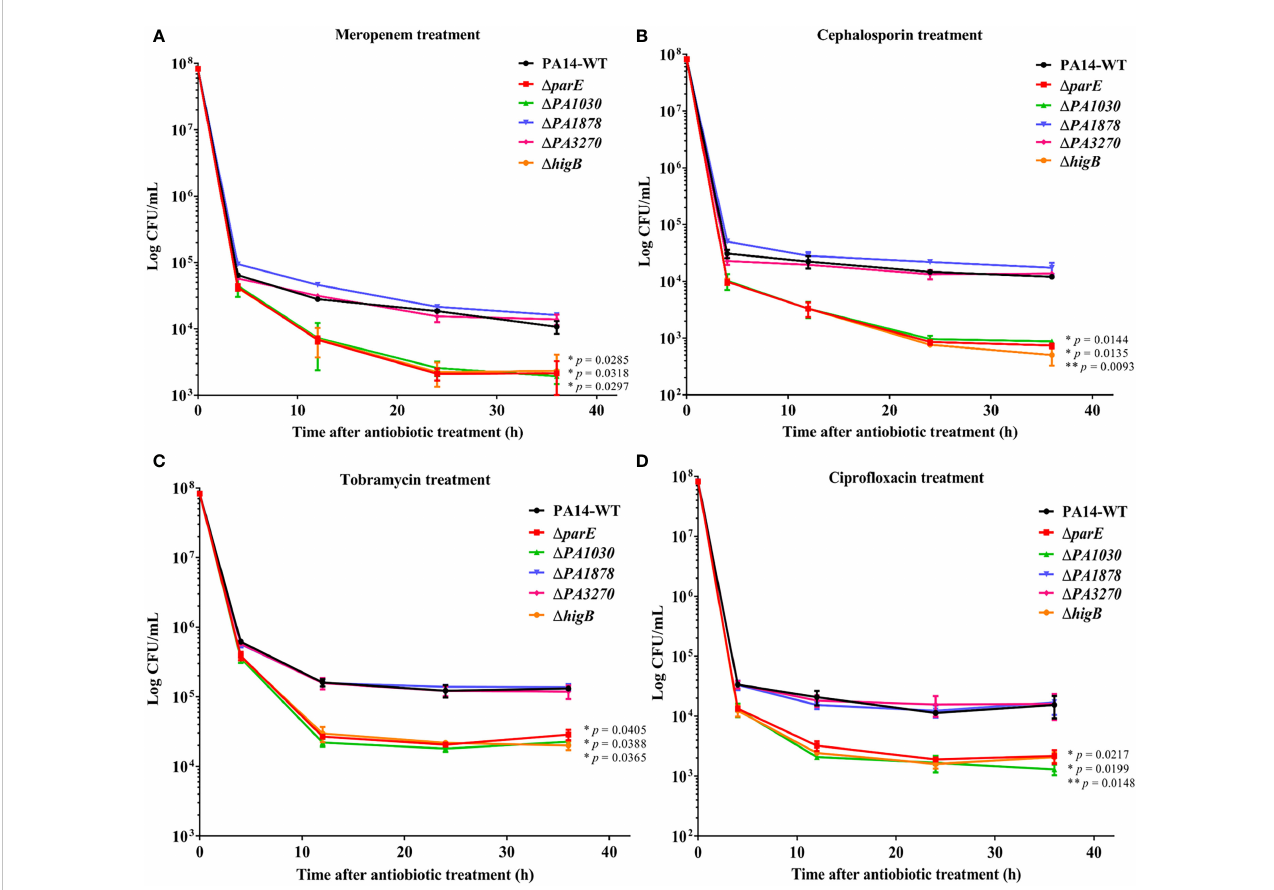
FIGURE 4 The ParE, PA1030, and HigB toxins increase the levels of antibiotic-tolerant persisters in P. aeruginosa . Overnight bacterial cultures of WT P. aeruginosa and mutants were re-inoculated into fresh LB medium at OD 600 = 0.1 and grown to an OD 600 of 1.0. Then the bacterial cultures were exposed to 50 µg/ ml meropenem (A) , 100 µg/ml cephalosporin (B) , 5 µg/mL tobramycin (C) and 5 µg/mL cipro fl oxacin (D) . Cell viability (CFU/ml) was determined by serial dilution and plating at the time points. The plate was incubated at 37°C for 16 h before colony counting. The results are shown as time-kill curves and expressed as the means±s.d. of 3 independent experiments (n=3). Statistical signi fi cance was calculated with a two-tailed unpaired t-test. * p <0.05; ** p <0.01 compared to survival of the WT strain at